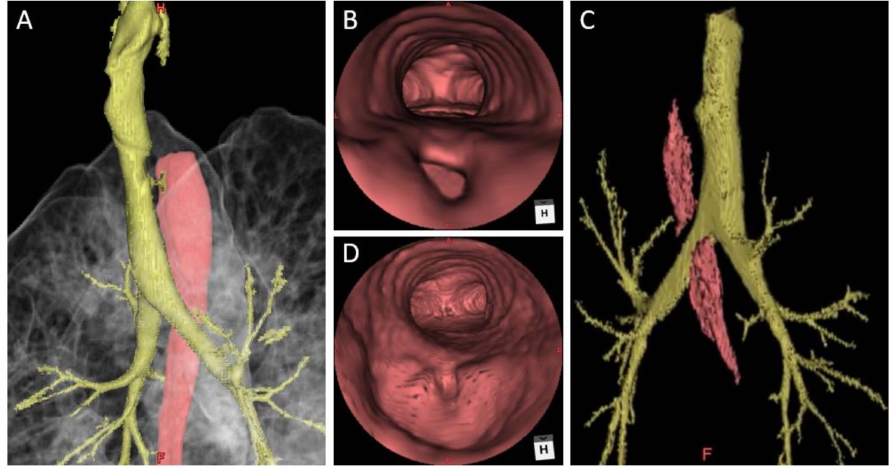
Figure 2. Three-dimensional (3D) reconstruction scans before and after thoracoscopic repair of the patient. ( A ) The pre-op 3D scan demonstrated the location of the fistula; ( B ) The virtual bronchoscopic view showed the tracheoesophageal fistula (TEF); ( C ) The post-op 3D scan demonstrated no recurrence of fistulization; ( D ) The virtual bronchoscopic view showing no visible TEF. (H: head, F: front)